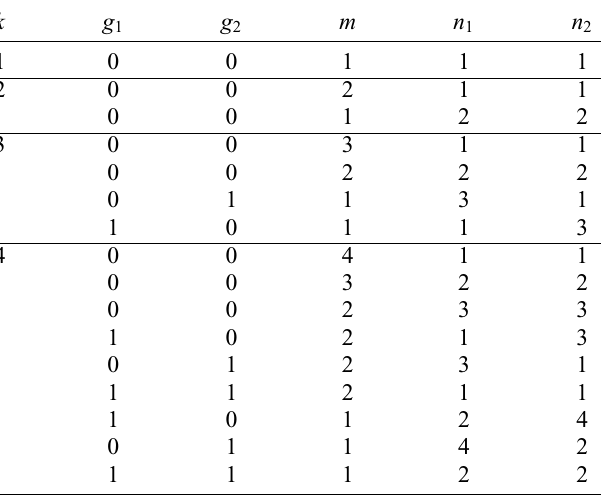
TABLE II. Subgraph genus and number of loops for each sub- system in Tr[ (ρ T 2 ) k ] diagrams in Eq. (B4). For instance, the corresponding diagrams for k = 3 are shown in Eq.